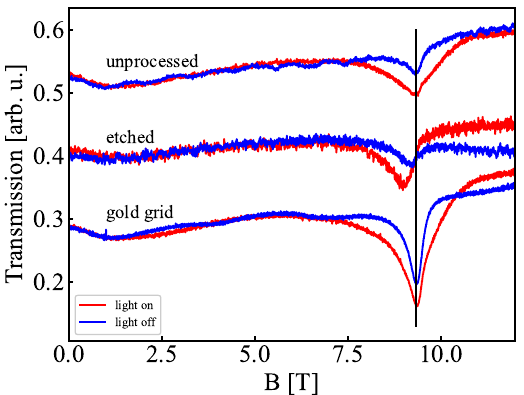
Figure 7. Influence of illumination with white light on transmission spectra on unprocessed sample and samples with Au and etched grating of the period equal to 8 µ m. The wavelenght of radiation was 118.8 µ m. The vertical bar shows position of the CR in unprocessed